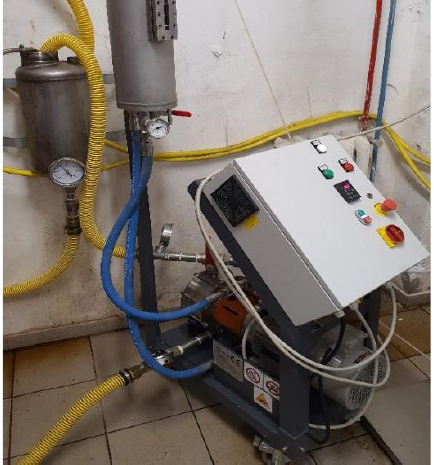
Figure 2. Rotor/stator HC reactor (EPIC Srl) at DSTF — University of Turin.